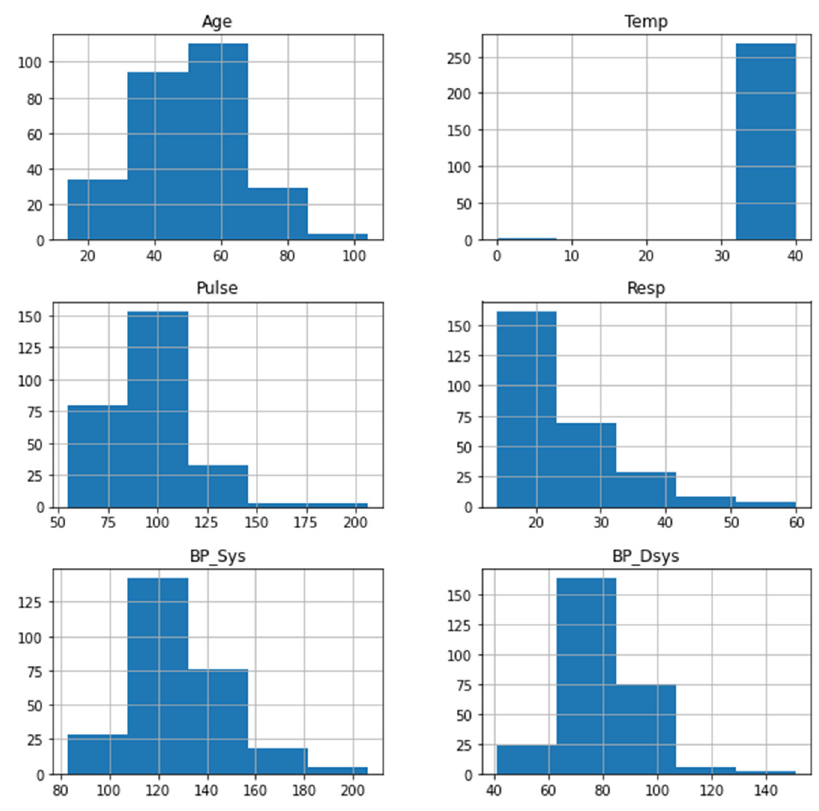
Figure 1. Exploratory analysis of the numeric attributes.